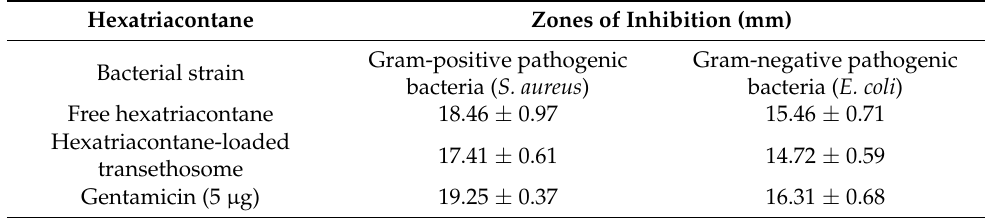
Table 4. Antimicrobial screening test of free hexatriacontane and HTC-TES (10 mg/mL) against some of the bacterial strains .